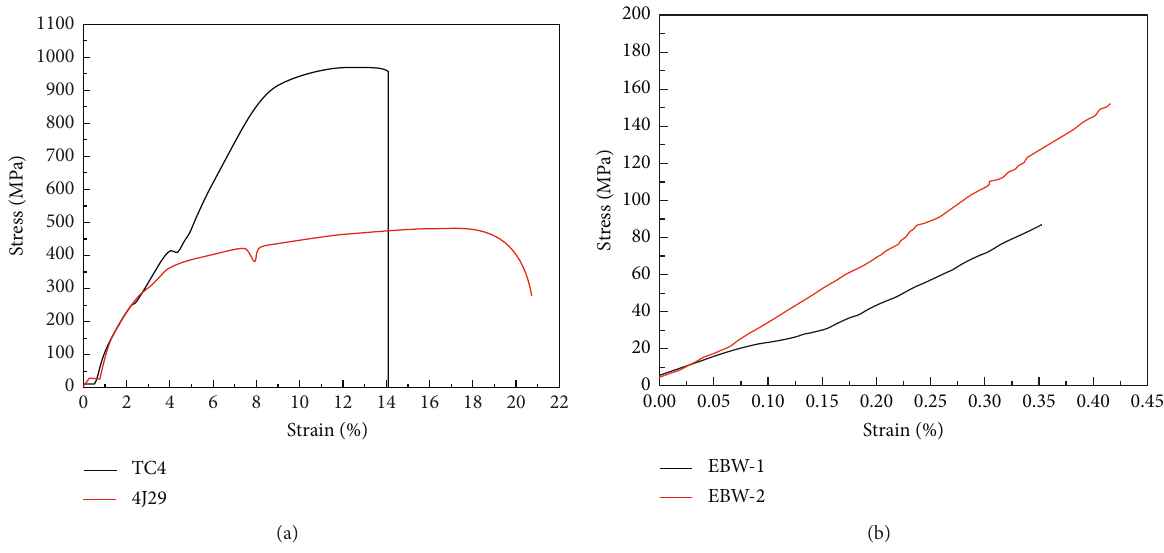
Figure 10: The tensile curves of the welded joint and the substrate: (a) the substrate; (b) welded